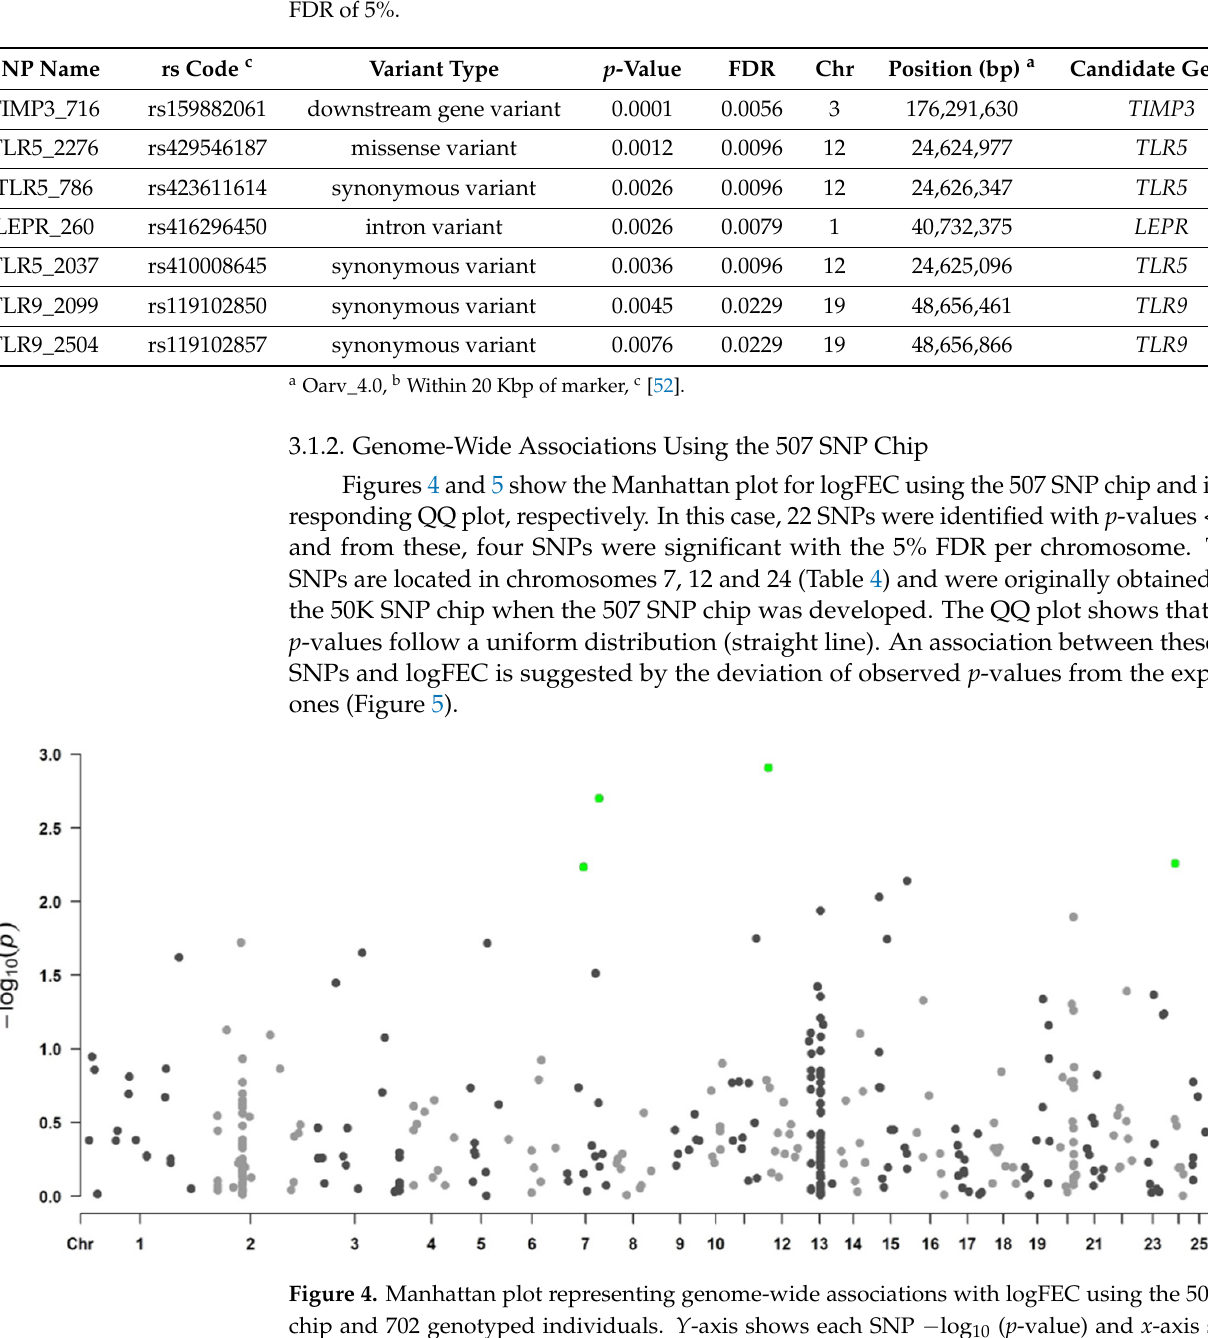
Figure 5. QQ plot of observed − log 10 ( p -values) (blue dots) and expected − log 10 ( p -values) (red dashed line) from GWAS results using the 507 SNP chip.